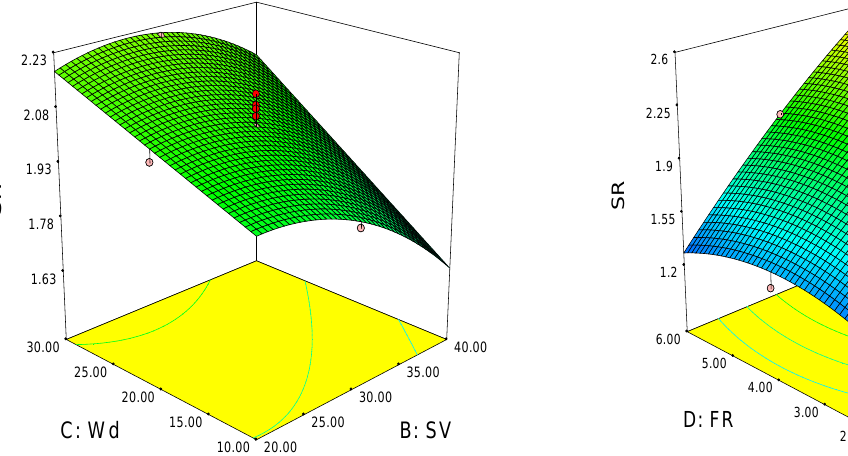
Fig. 5a. Combined effect of SV and Ton on SR Fig. 5b. Combined effect of W d and Ton on SR